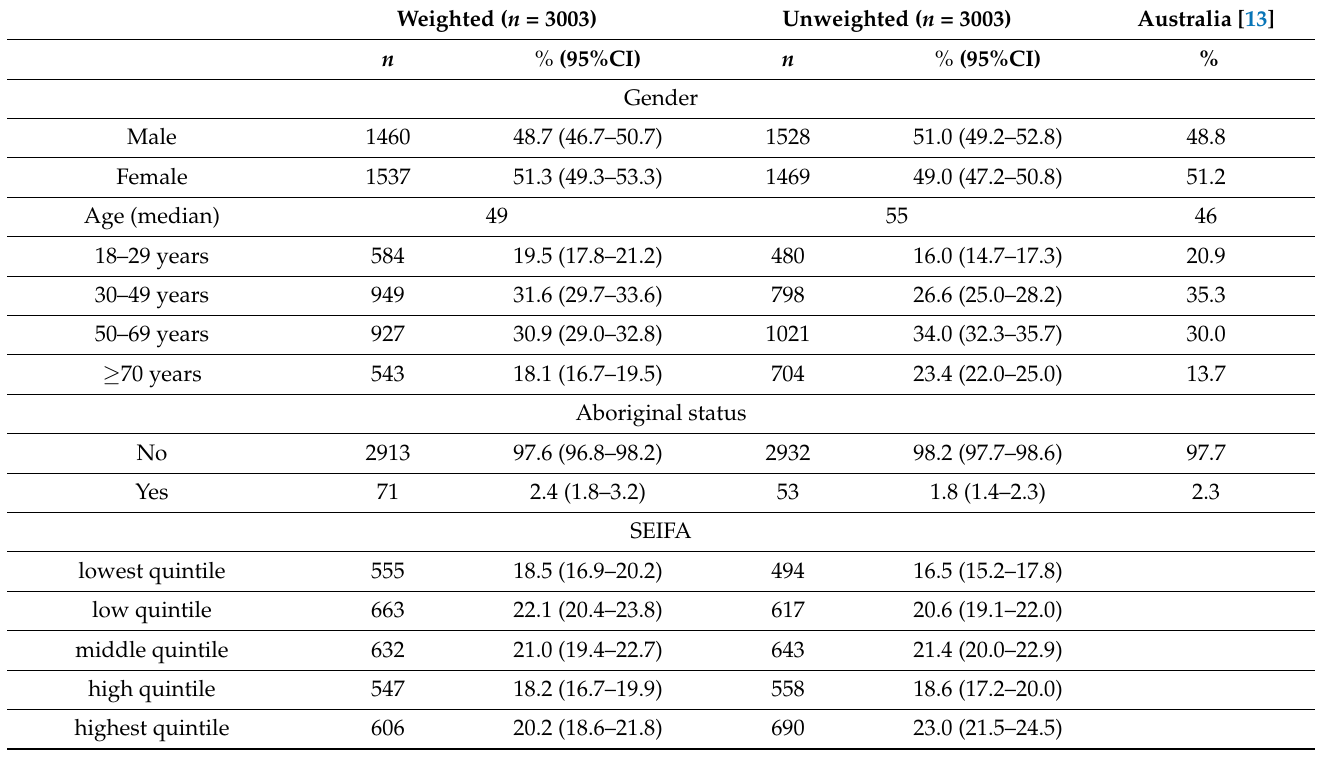
Table 1. Weighted and unweighted sociodemographic characteristics of all